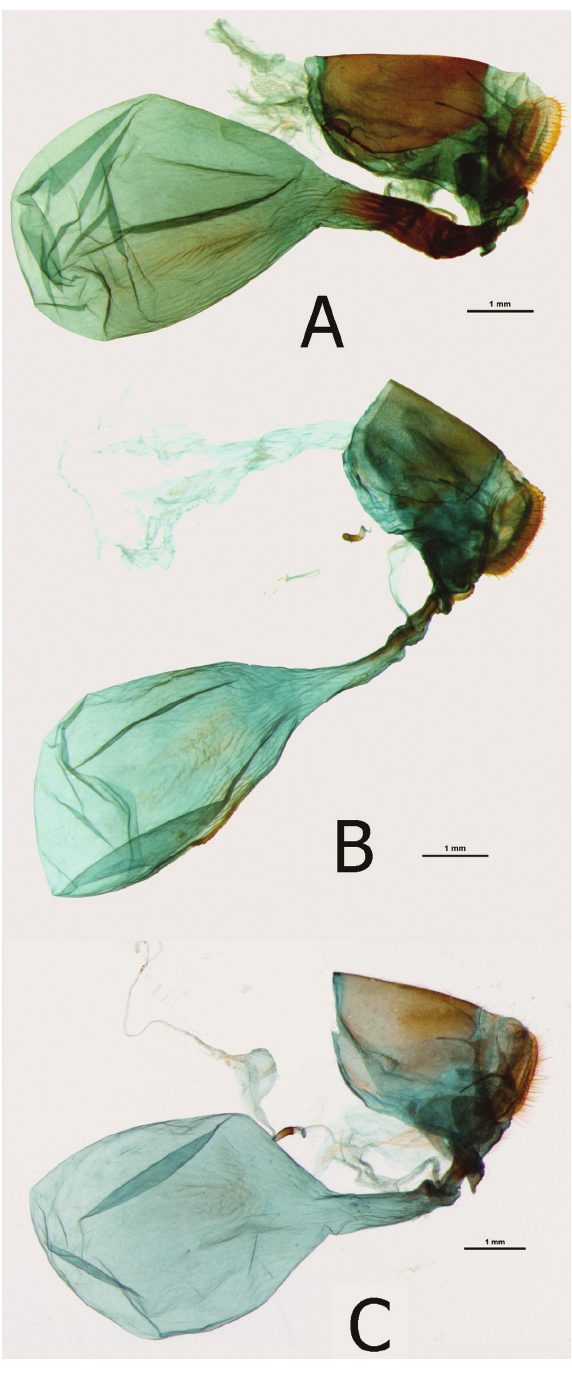
Figure 12. Female genitalia (in lateral view): A E. sarcoptera nipponicorum Kigoma, Tanzania B Euphae- dra sarcoptera ferrea Mont Nimba, Guinea C Euphaedra sarcoptera nipponicorum Mbandaka,